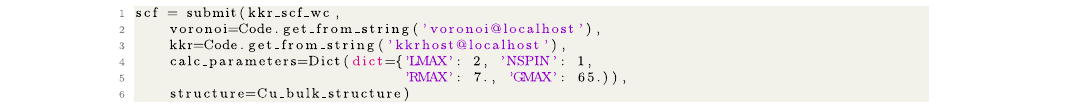
Fig. 3 Submission of a self-consistency work fl ow for bulk Cu. The crystal structure is speci fi ed with the structure input and basic KKR- speci fi c parameters, that control the accuracy of the calculation, are set in the calc_parameters input node. Here submit , Dict and Code are basic AiiDA methods and